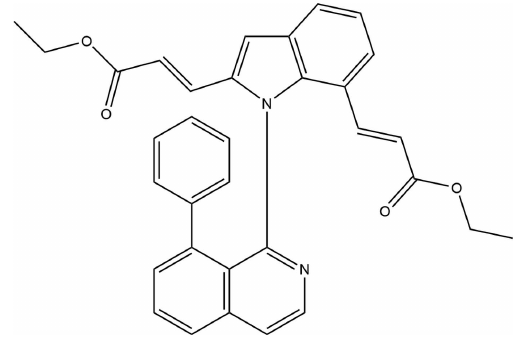
Table 1 Hydrogen-bond geometry (A˚ , (cid:2) ).